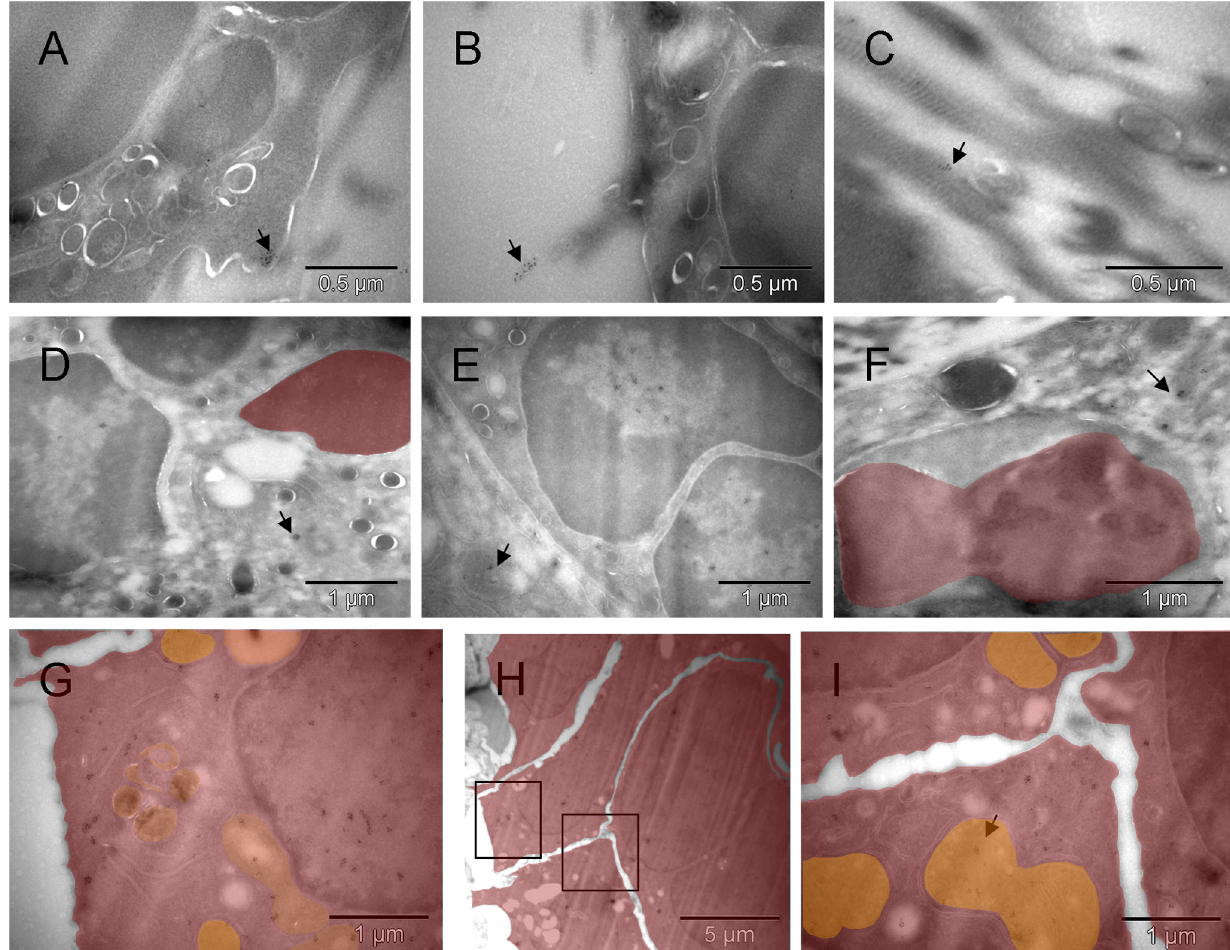
Figure S4. HSCs and their progenitors at the tumor site labeled with CD34 marker. Clusters of the gold label were found on the cell surface, in the nucleus, cytoplasm and mitochondria of cells morphologically fitting the description of erythroblasts [ A , B , D & E ] and on extracellular collagen fibers produced by them [ B & C ]. A fragment of cell with mixed phenotype is shown in [ F ]. The cluster of CD34-labeled giant erythroblasts (red), potentially leading to myeloplaxes, contained one cell with a double nucleus (right side in [ H ]). Two regions of [ H ] are enlarged in [ G & I ], left and right respectively, to show oversized mitochondria (orange), some converting into peroxisomes (dark & orange) [ G ]. That cluster of cells was bigger than the one shown earlier (Figure S3C), and the presence of mitochondria despite clear commitment to erythropoiesis suggested that here the process was more efficient. Arrows point out some clusters of Au grains.